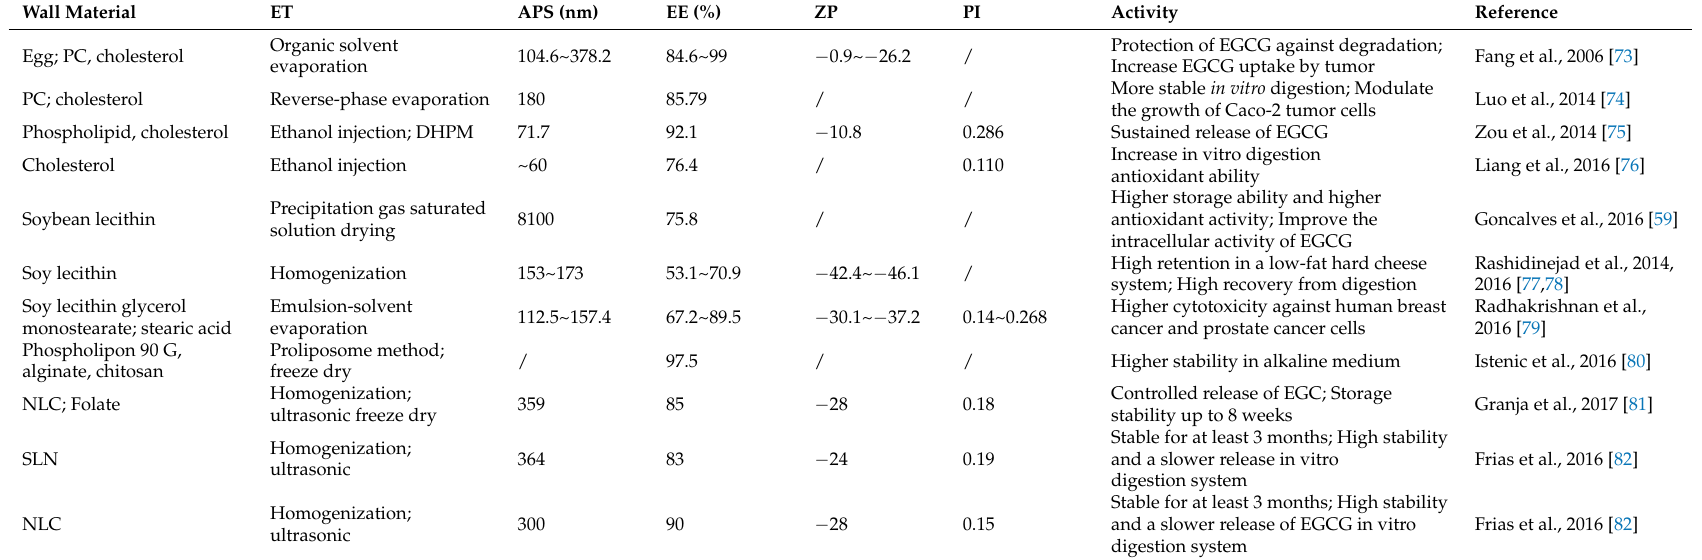
Table 3. Overview of studies on the effect of lipids based encapsulation on